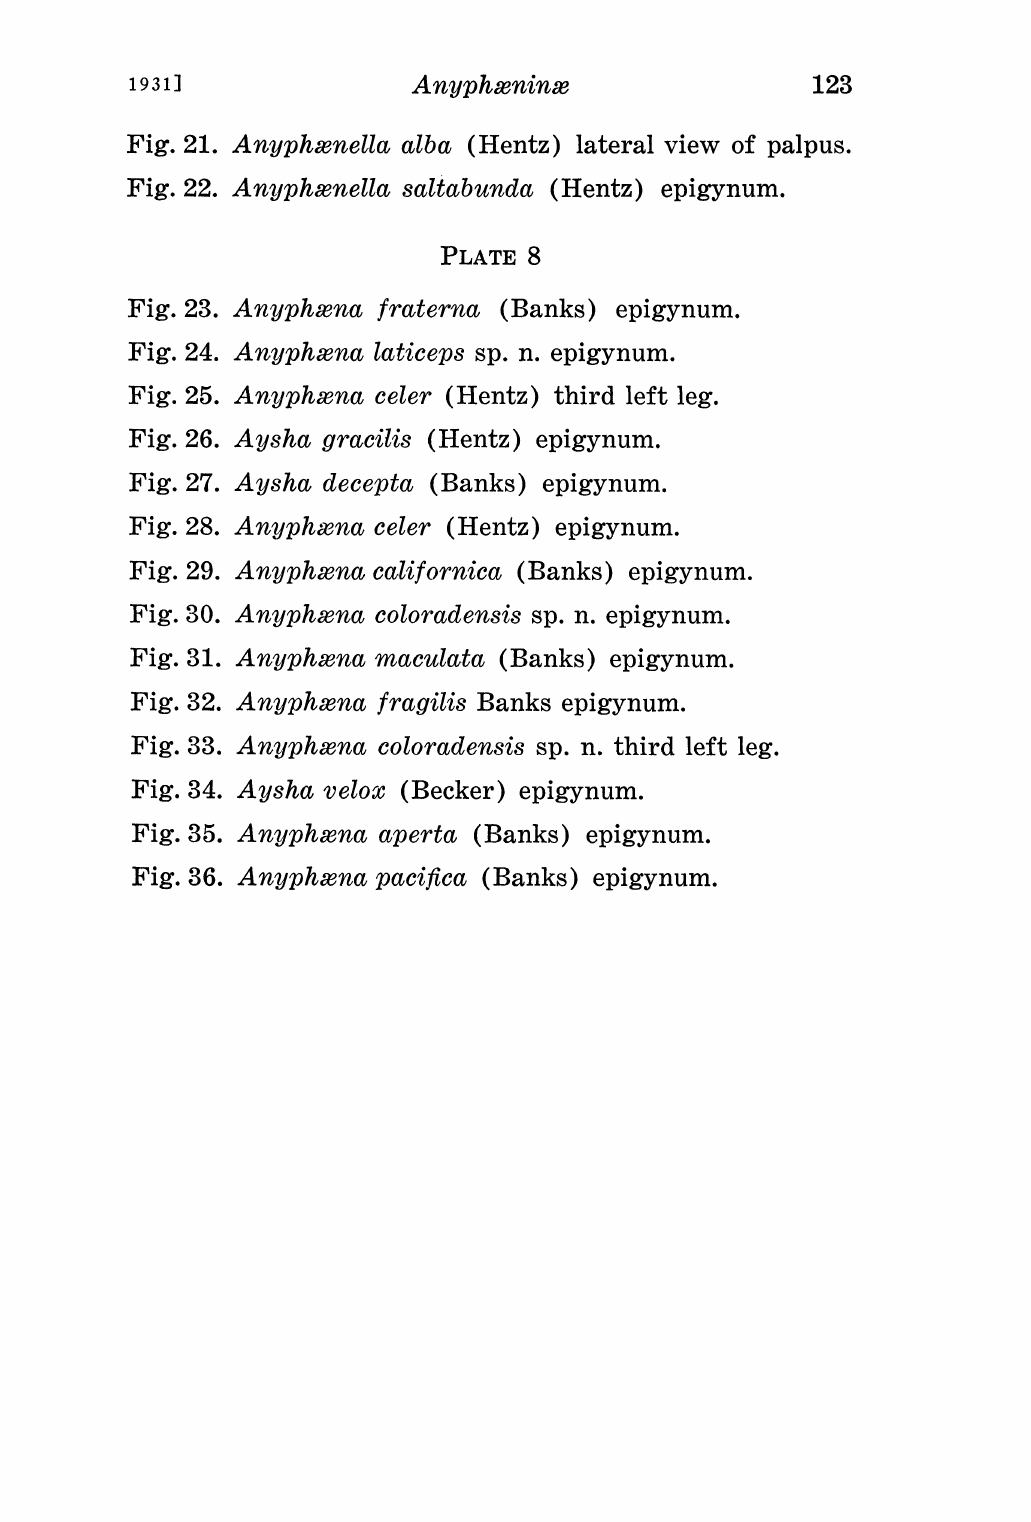
Fig. 21. Anyphxnella alba (Hentz) lateral view of palpus. Fig. 22. Anyphxnella saltabunda (Hentz) epigynum.